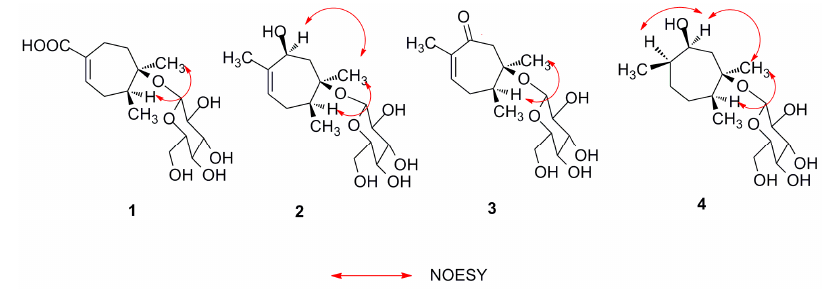
Figure 3. Key NOESY correlations of compounds 1 – 4 .